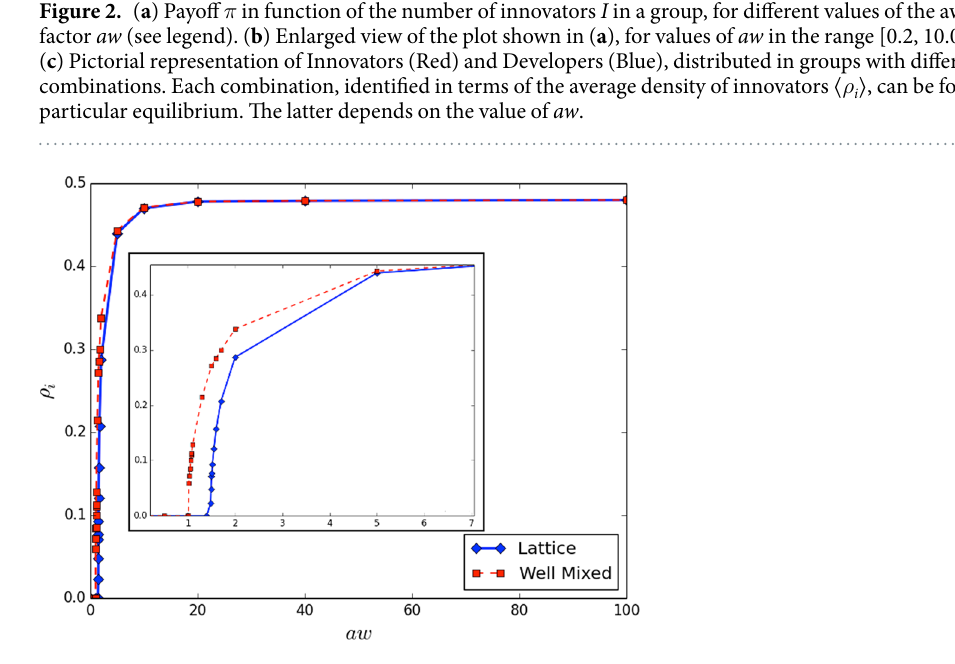
square lattice is L = 100. In addition, setting G = 5, each agent in the lattice belongs to 5 different groups, there- fore also for the well-mixed case we consider this scenario. Now, it is important to emphasize that comparing the dynamics of the model in the two described configurations has two main motivations. First, we can evaluate if the “network-reciprocity” effect 60 supports innovation, as it does for the cooperation in dilemma games (e.g., ref. 40). Second, the well-mixed case allows to represent a sort of “mobility” effect, so that we can evaluate its influence in the dynamics of the population, which can be helpful to shade light on the hypothesis that mobility is able to sup- port innovation. Figure 3 shows the density of innovators ρ i , at equilibrium (or after 10 8 time steps), in function of aw . As expected, for high values of aw , both configurations show that the density of innovators slowly tends